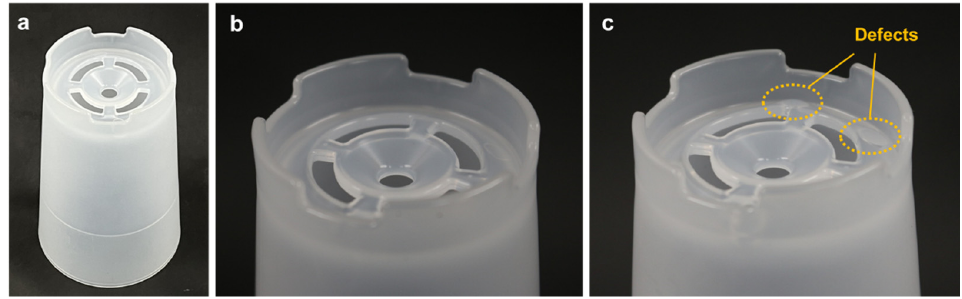
Figure 15. Photographs of the molded part after 10 s cooling: ( a ) TPMS conformal cooling (entire part). ( b ) TPMS conformal cooling (upper region). ( c ) Baffle cooling (upper region).